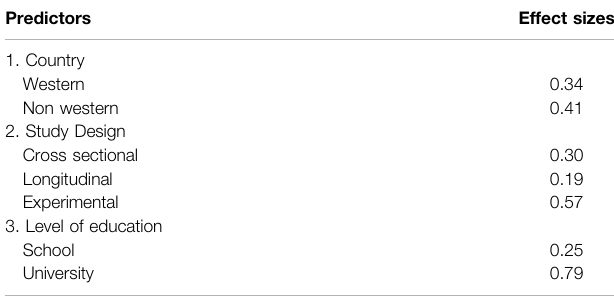
TABLE 4 | Predicting difference in effect